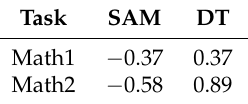
Table 4. Difference in self-reported scores, compared to baseline measurement.